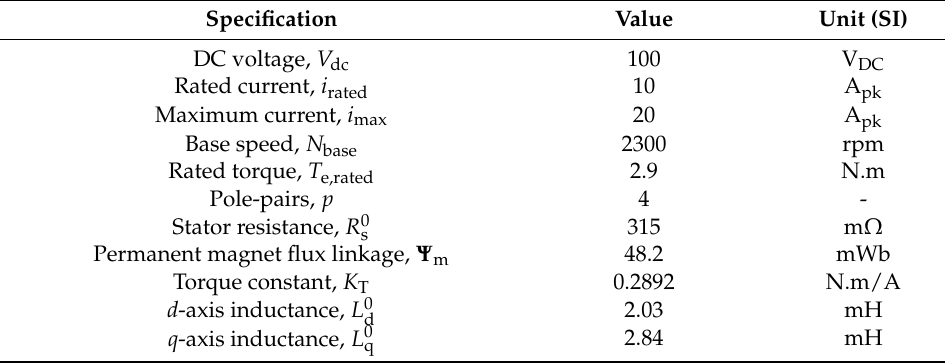
Table 1. Target IPMSM